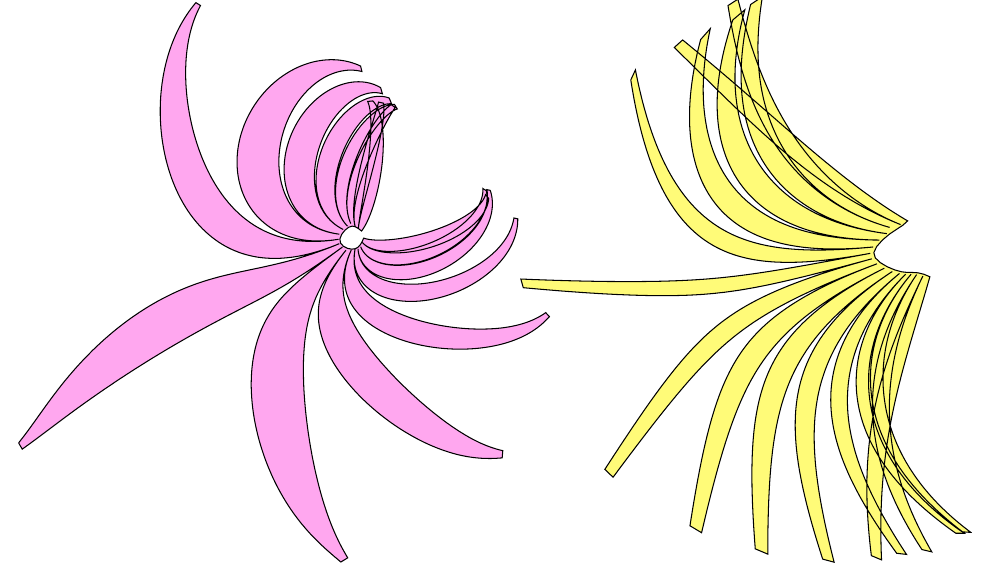
Figure 24. Developed surfaces before and after a perspective homography transformation. The outline on the right is the untransformed shape developed, and the outline on the left is the developed version of the transformed